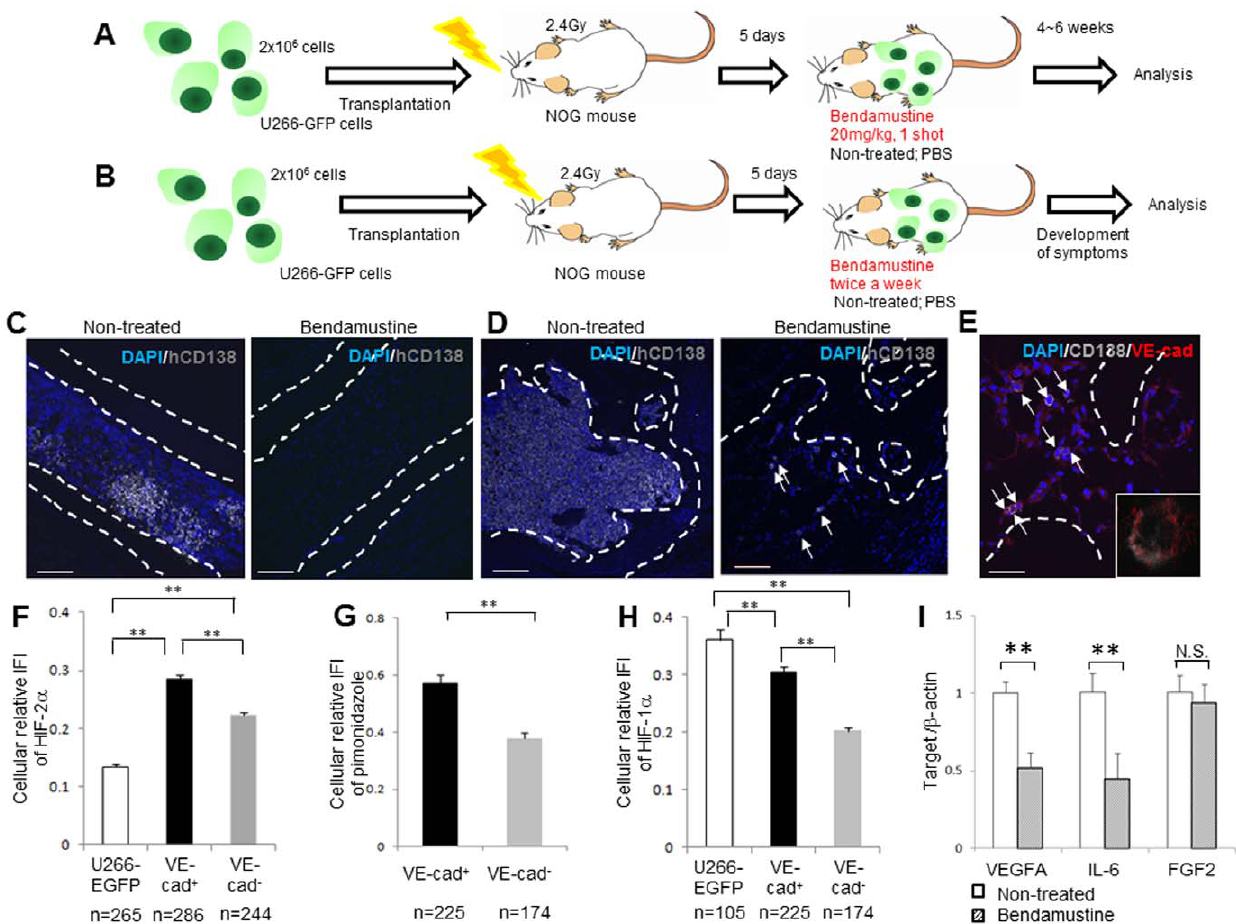
Figure 4. Bendamustine-treated MM cells remaining at the metaphyseal region express VE-cadherin and show hypoxic phenotypes. A. A single dose of bendamustine (20 mg/kg) or an equivalent amount of PBS was administered intraperitoneally to engrafted mice 5 days after U266-EGFP cell transplantation. Four to six weeks after administration, mice were sacrificed for analysis. B. Over the course of a week, two sequential doses of bendamustine (20 mg/kg) or equivalent amounts of PBS were administered intraperitoneally to engrafted mice 5 days after U266-EGFP cell transplantation. These mice were sacrificed for analysis when the mice had developed disease symptoms. C, D. IHC of human CD138 (gray) at the diaphyseal region ( C ) or the metaphyseal region ( D ) at 4 weeks after treatment in bendamustine-treated mice (right panel) or non-treated (PBS-treated) mice (left panel). Representative data from five fields of the BM of two mice per group in two independent experiments are shown. In A and B, the left bars=200 m m, and in B, the right bar=100 m m. E. Double IHC of human CD138 (gray) and VE-cadherin (red) at 4 weeks after treatment in bendamustine-treated mice. The arrows indicate human CD138-positive MM cells. Representative data from five fields of the BM of two mice in two independent experiments are shown. Bar=50 m m. F–H. Quantification of HIF-2 a ( F ) or HIF-1 a ( H ) protein levels in cultured U266- EGFP cells, or VE-cadherin + or VE-cadherin 2 fractions, 6 weeks after U266-EGFP cell transplantation and quantification of pimonidazole retention ( G ) in VE-cadherin + or VE-cadherin 2 fractions at 6 weeks after transplantation. The experiment was performed twice with similar results. I. Human CD138 + mouse CD45 2 MM cells were sorted from non-treated or bendamustine-treated mice, and VEGFA, IL-6 or FGF-2 transcripts were examined by qRT-PCR. Each value was normalized to b -actin expression (mean 6 SD, ** P , 0.01, n=4). The experiment was performed twice with similar